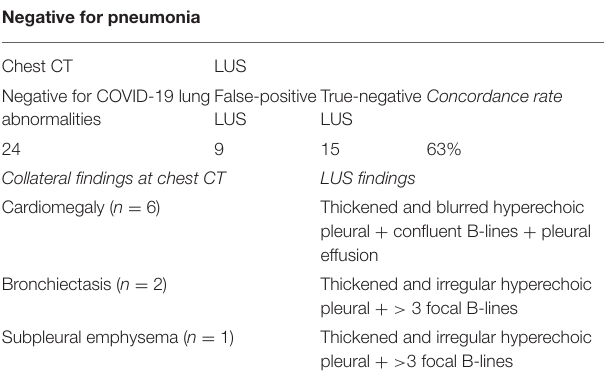
TABLE 5 | Concordance rate between LUS and CT in patients with initial severe CT scan findings.